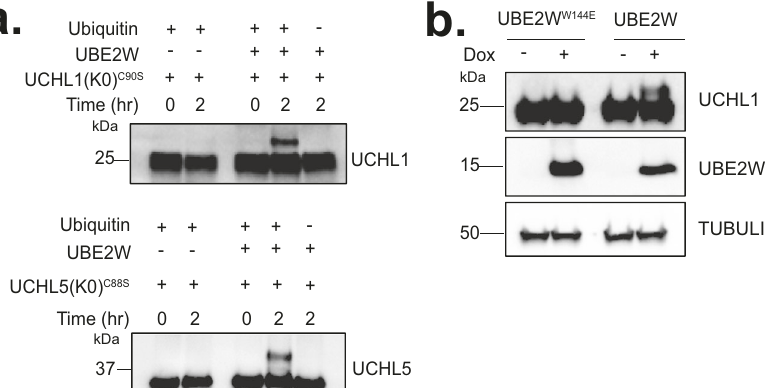
Fig. 7 UCHL1 and UCHL5 are substrates of UBE2W. a In vitro ubiquitination assays were performed on lysine-less (K0) catalytically inactive UCHL1 C90S (top) and UCHL5 C88S (bottom). Two-hour reactions were carried out in the absence of UBE2W (lane 1 and 2) and the presence of UBE2W (lane 3 – 5). All reactions were incubated with E1, E3 (RNF4), ATP/MgCl 2 , and with (lane 2) or without (lane 5) ubiquitin. Results are representative of three independent experiments. b Western blots of doxycycline-inducible UBE2W/RNF4 and UBE2W W144E /RNF4 HEK293 cells at 24 h post doxycycline treatment. Endogenous UCHL1 expression was analyzed with an anti-UCHL1 antibody. Results are representative of three independent experiments. Source data are provided as a Source Data fi